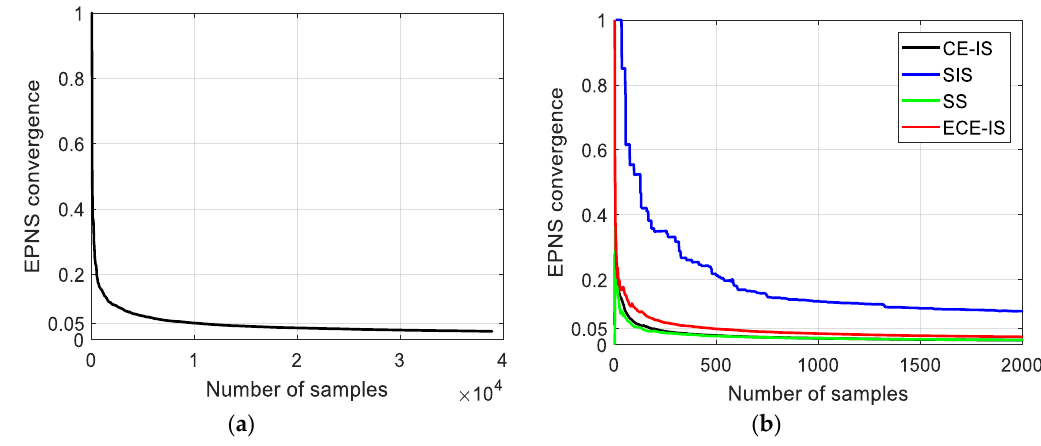
Figure 13. ( a ) System EPNS convergence in case of using MCS method; ( b ) system EPNS convergence in case of using CE-IS, SIS, SS, and ECE-IS approaches.